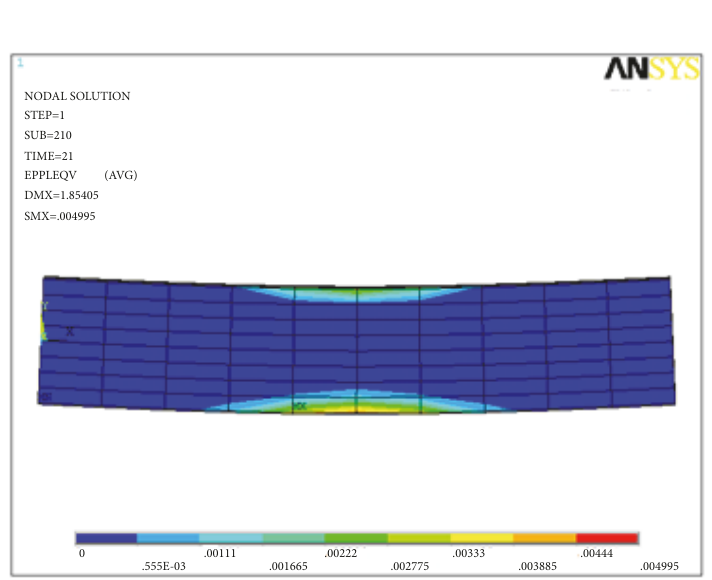
Figure 8: The plastic zone analyzed by